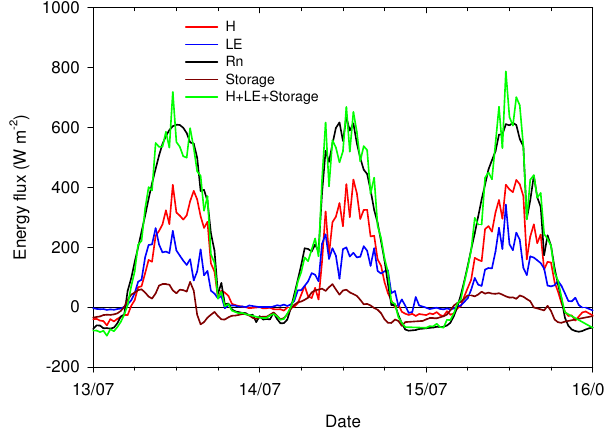
Fig. 3. The estimated biomass storage flux from different height intervals and the biomass storage flux from branches plus needles during the three summer days. The data shown here are scaled to the pine portion of the stand.